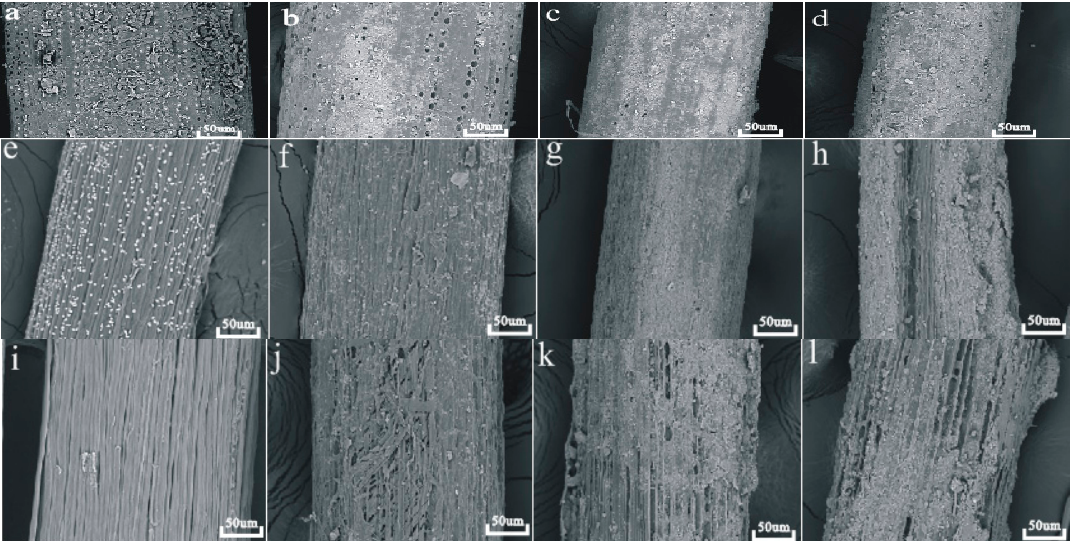
Figure 1. SEM images of the surface morphologies of windmill palm fibers, before and after 30-, 60-, and 90-day soil burial. Untreated windmill palm fiber ( a ); after biodegradation in soil for 30 days (WPF30) ( b ); 60 days (WPF60) ( c ); and 90 days (WPF90) ( d ). Alkali-treated fibers (AF) ( e ); after biodegradation in soil for 30 days (AF30) ( f ); 60 days (AF60) ( g ); and 90 days (AF90) ( h ). Bleached fibers (BF) ( i ); after biodegradation in soil for 30 days (BF30) ( j ); 60 days (BF60) ( k ); and 90 days (BF90) ( l ).